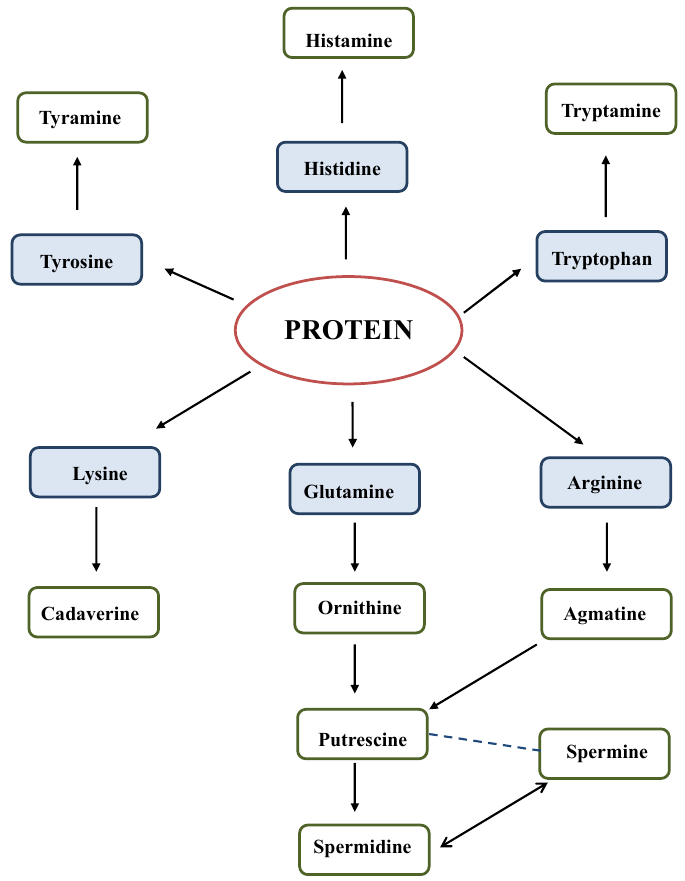
Figure 3. BA Figure 3. BA biosynthesis .